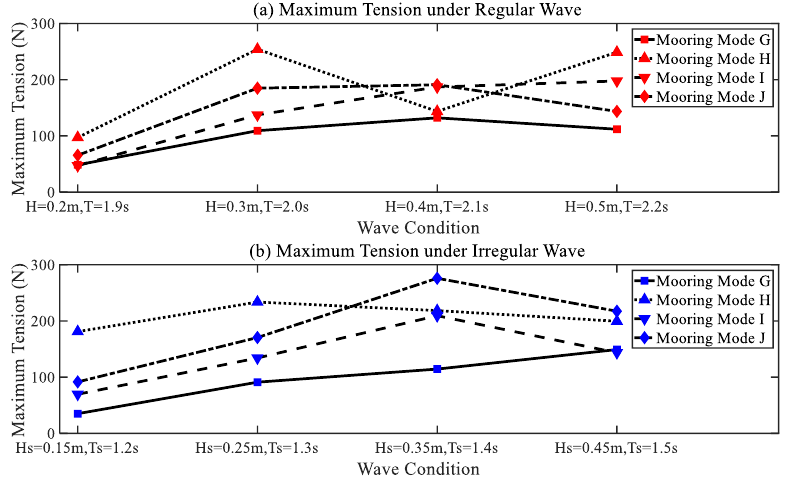
Figure 10. The maximum tension on the anchor line of the three-anchor line mooring mode.